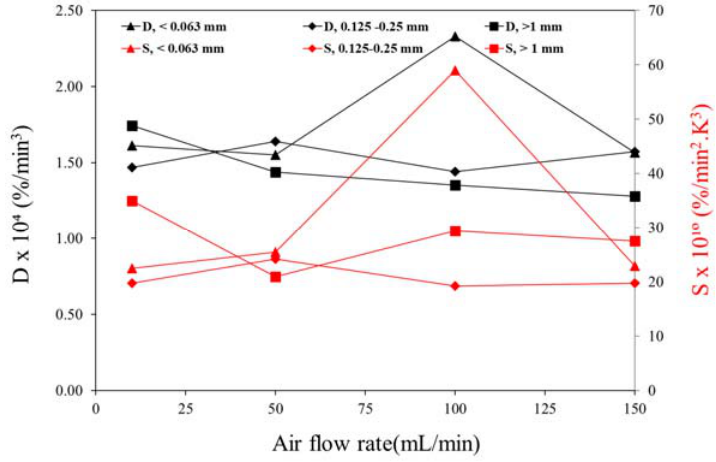
Figure 8. Combustion indexes of the pine wood particles at different heating rates.